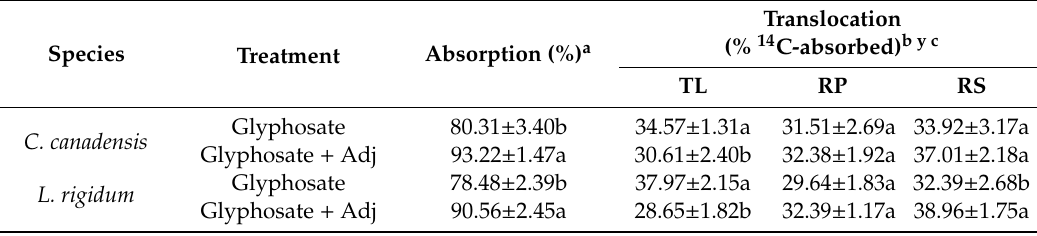
Table 3. 14 C-glyphosate absorption and translocation 96 HAT in C. canadensis and L. rigidum populations.